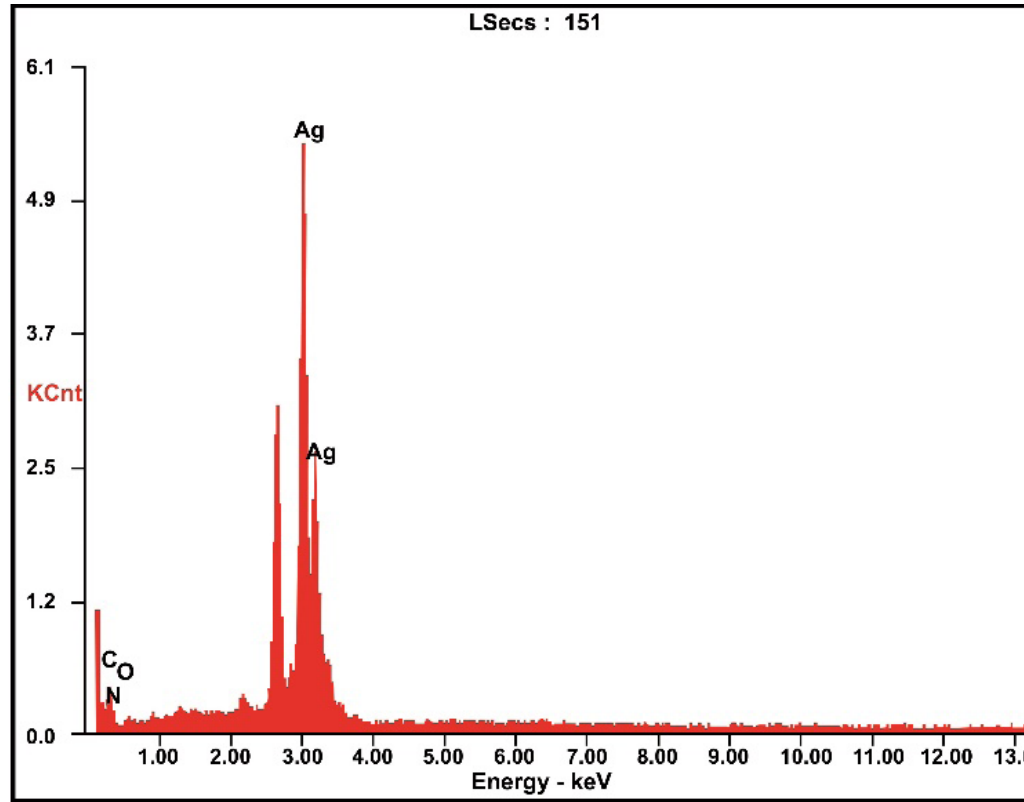
FIGURE 3 - EDAX spectrum of M. arvensis Linn. mediated silver nanoparticles. [Spectrum showing peaks corresponding to C, O, N and Ag